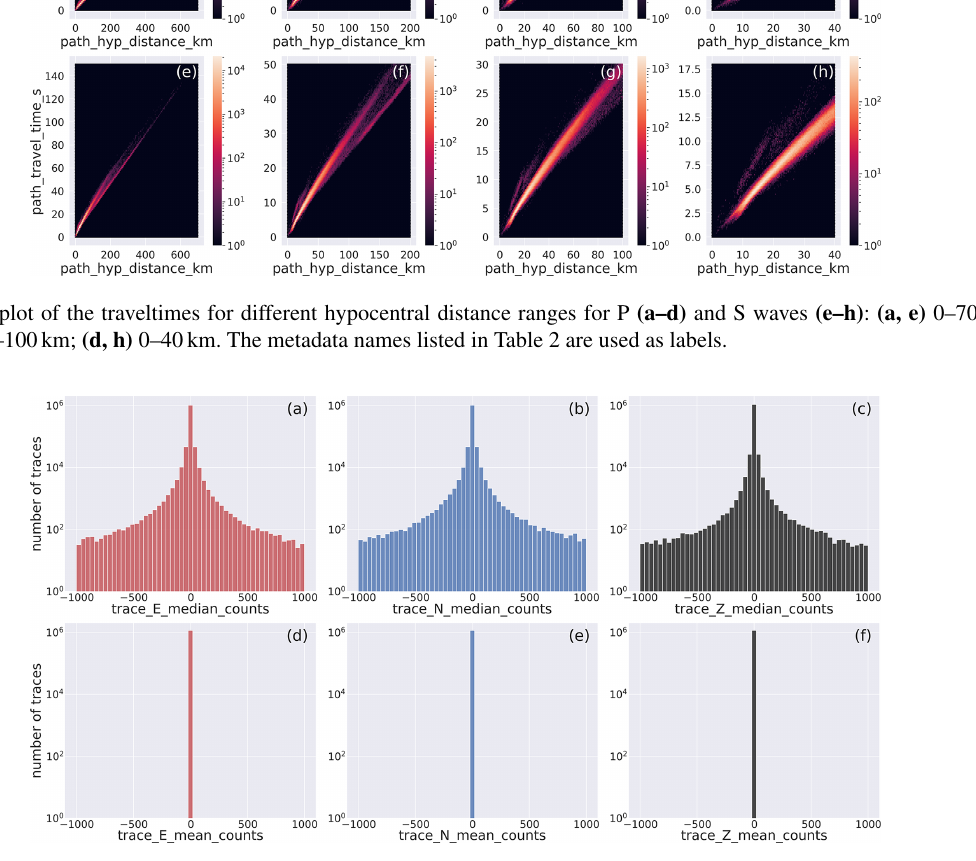
Figure 8. Close view of the histogram of the distribution of the median and mean values of the E -, N -, and Z -component earthquake waveform traces. The full distribution is shown in Fig. D2. Note that the mean values (d–f) are shown to the sole scope of reference. The metadata names listed in Table 2 are used as labels for the specific metadata being